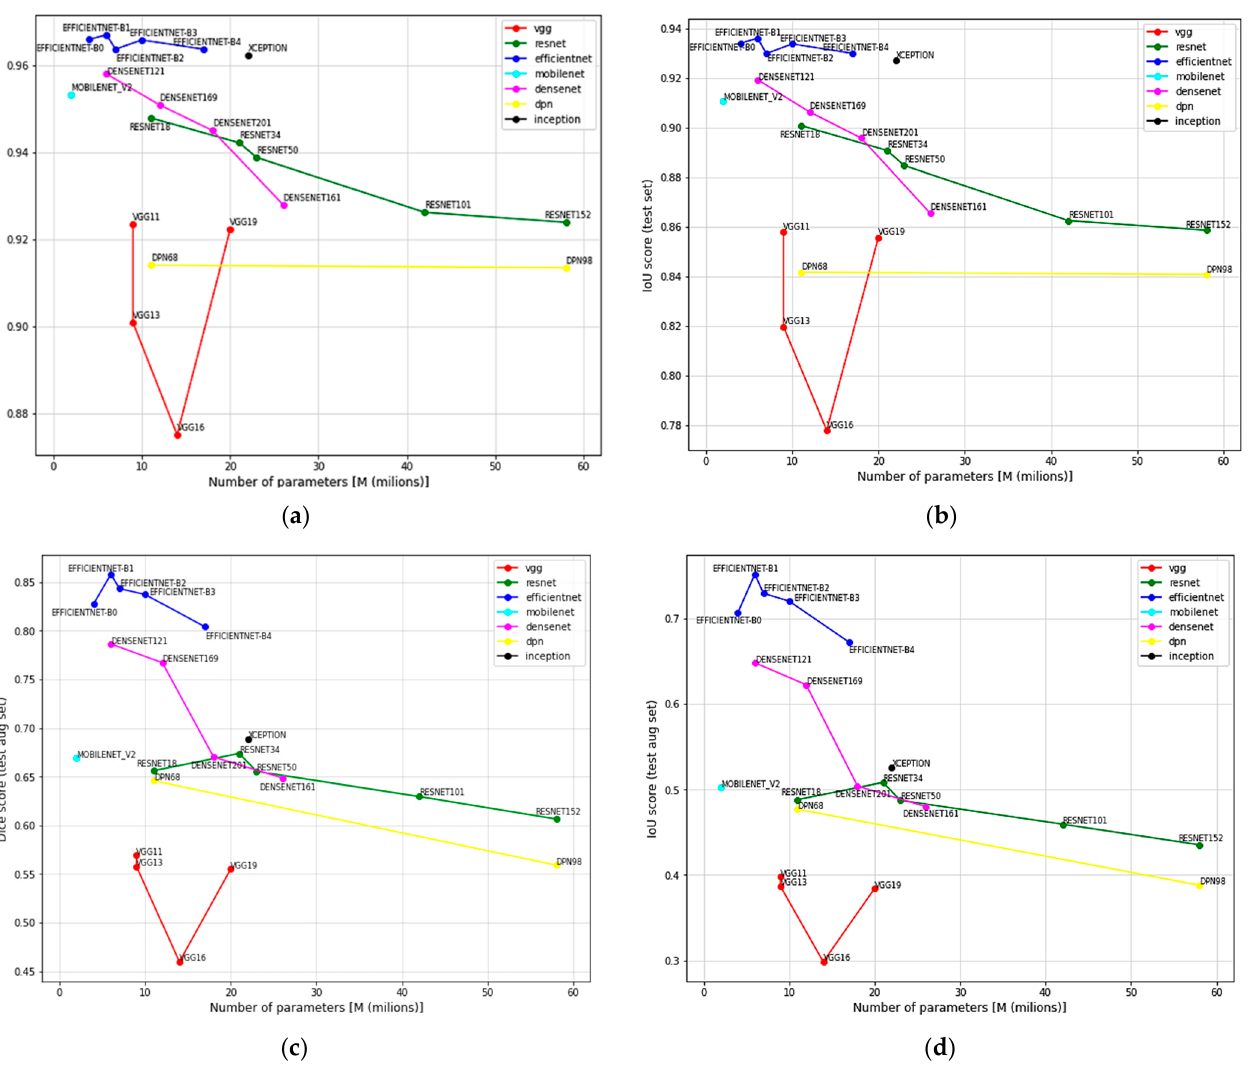
Figure 6. Comparison of different U-NET encoder models’ DICE and IoU evaluation scores on TEST ( a , b ) and TEST AUG sets ( c , d ). Table 3. EfficientNet encoders DICE and IoU scores on TEST and TEST AUG datasets. Best results are bold.